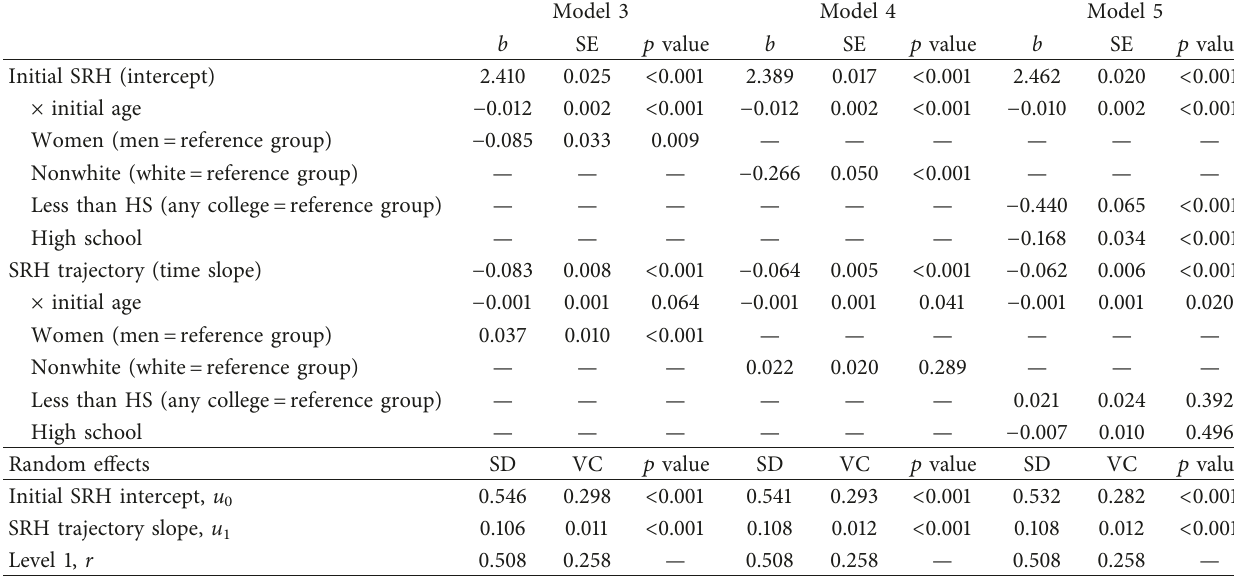
Table 4: Models 3–5: self-rated health trajectories by gender, race, and